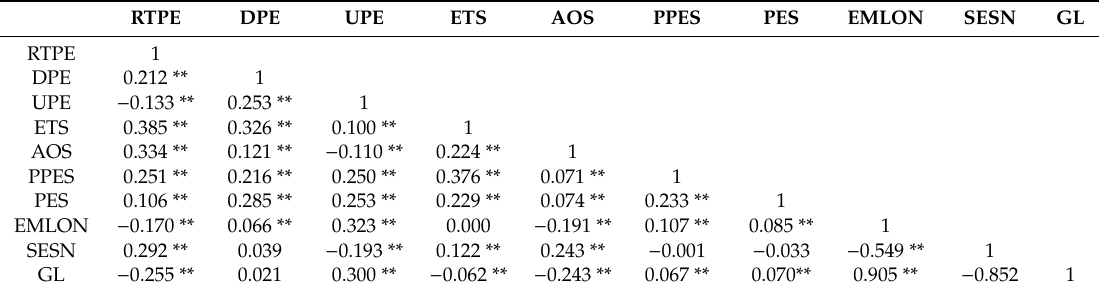
Table 5. Dimensions of attitudes towards Physical Education and